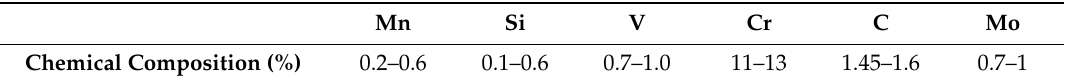
Table 3. Chemical composition of tool steel.